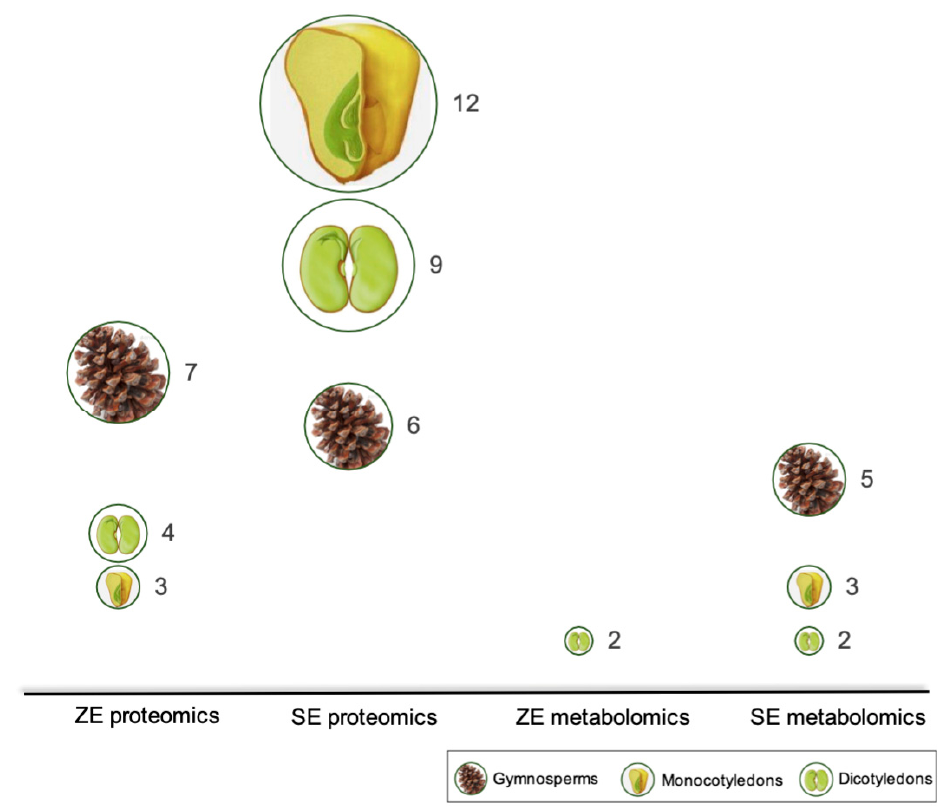
Figure 6. Number of publications on zygotic and somatic embryogenesis in angiosperms and gymnosperms using proteomic and/or metabolomic approaches in the last decade. Bubble and illustration size are proportional to the number of reviewed publications and plant group, respectively.